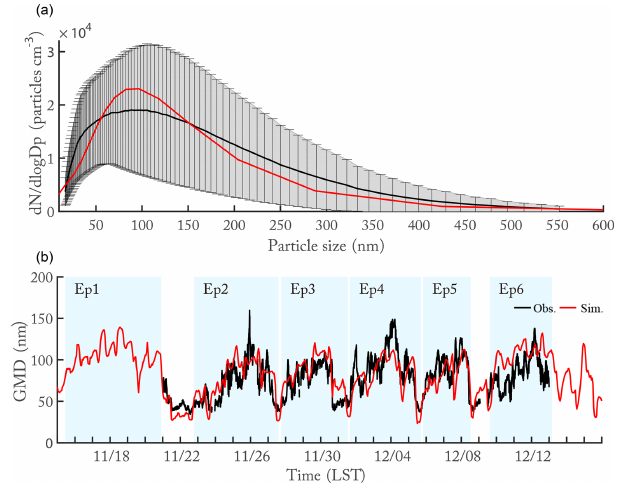
Figure 4. (a) Particle size distribution in Beijing at ground level. (b) Comparison of the geometric mean diameter (GMD) for parti- cles in the range of 16–600nm between observations and simulated values for Beijing. The black solid line and the red solid line repre- sent the observations (Obs.) and simulation (Sim.) results, respec-